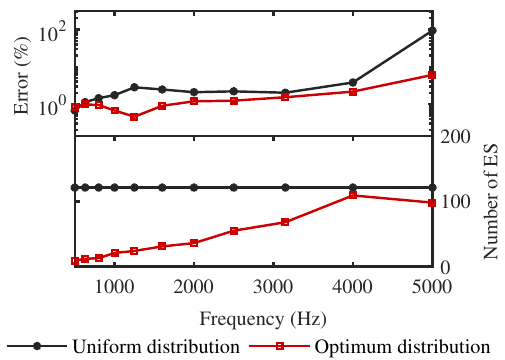
Figure 10. The relative error of the sound pressure ( top ) and the number of equivalent sources (ES) ( bottom ) versus